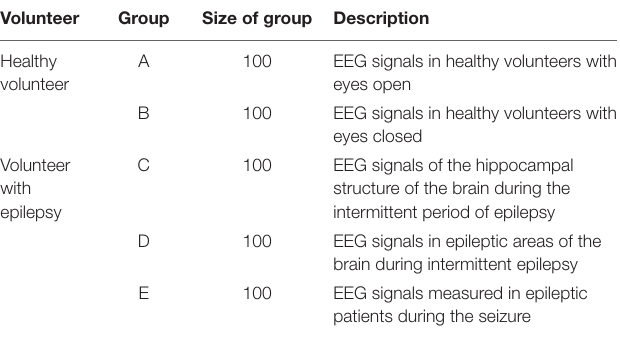
TABLE 1 | Description of the dataset.